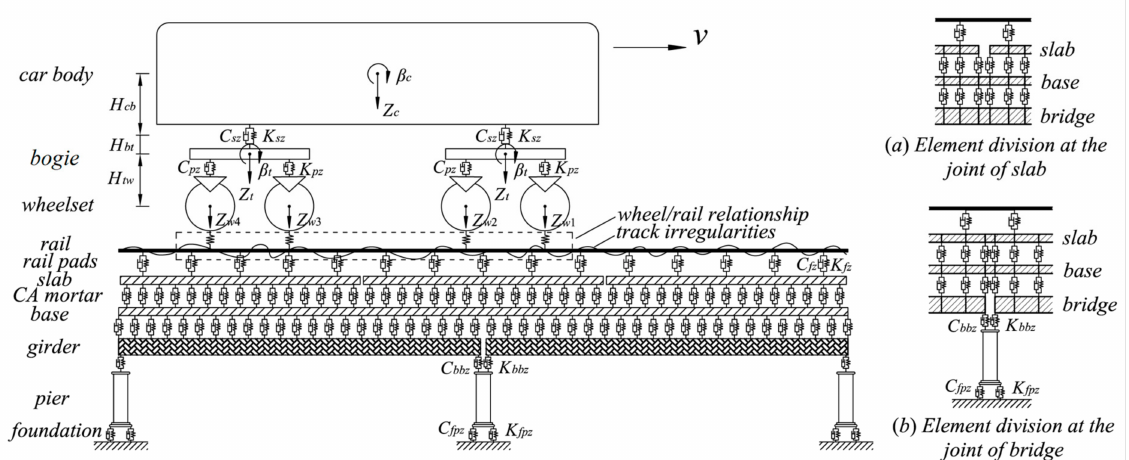
Figure 1. Side view of the nonlinear vehicle–track–bridge model